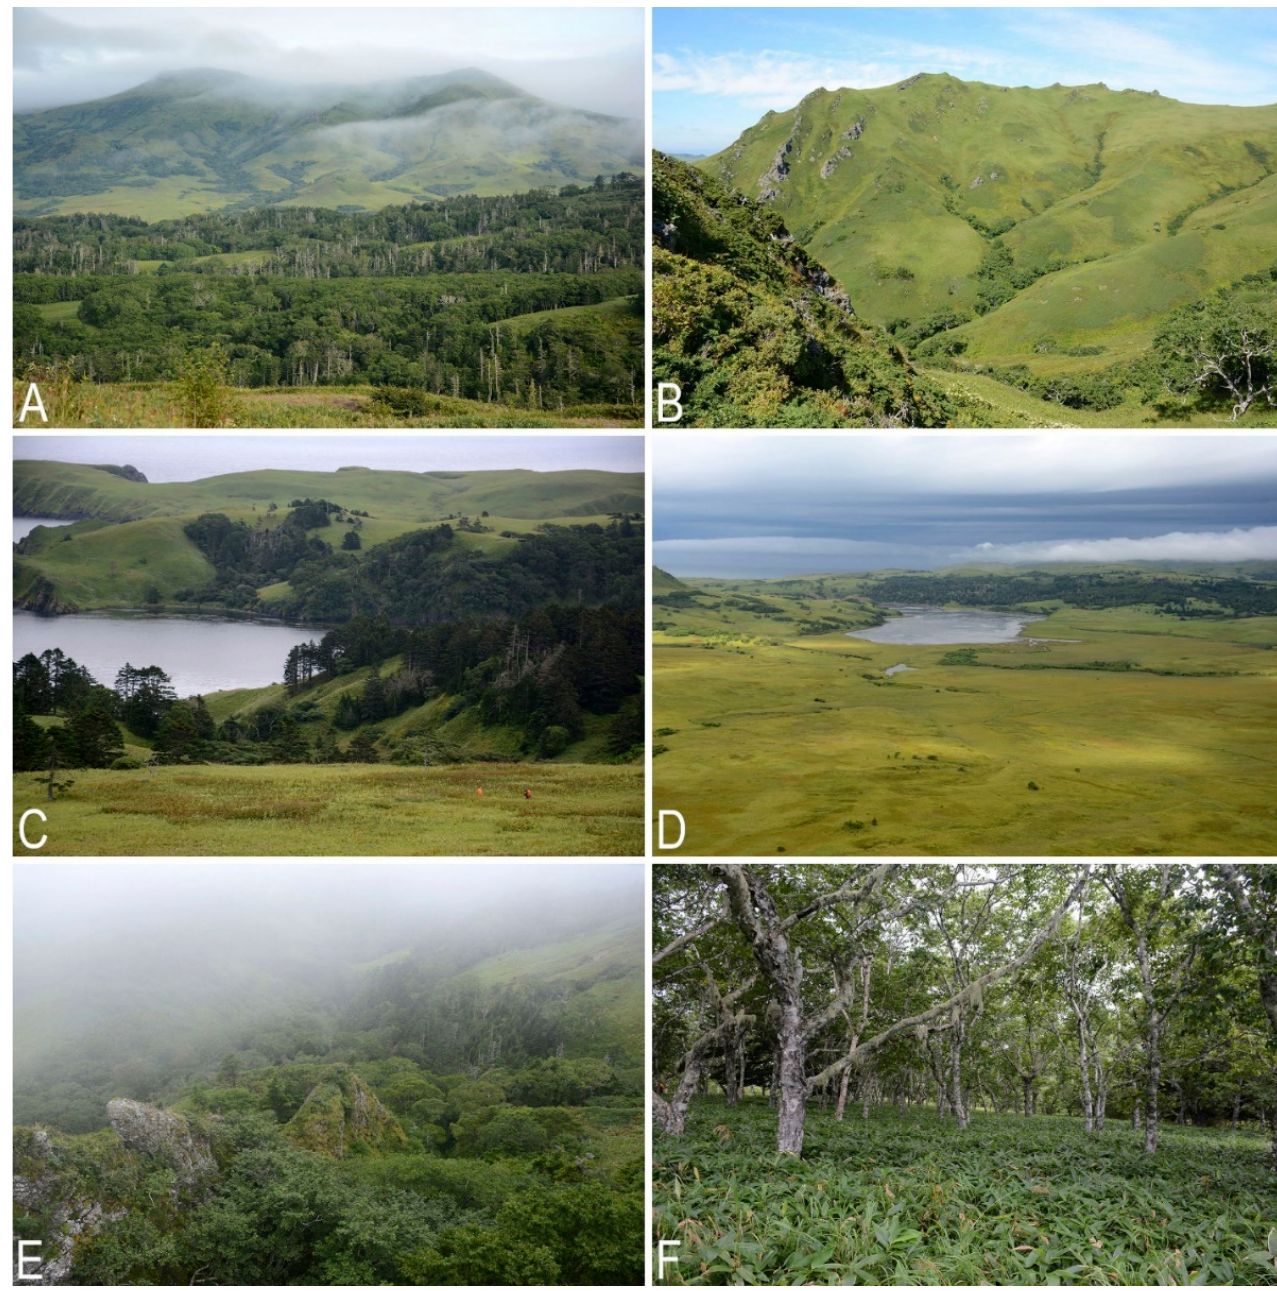
Figure 7. Liverwort habitats on Shikotan Island, southern part of the island: ( A ) Tomari Mt., view from the northwest, with Picea-Abies forests near the foot; ( B ) tundroid community ( Sasa, Eubotryoides, Empetrum , grasses, etc.) formed under severe wind condition, with low (less 50 cm in height) clumps of Juniperus sargentii , inner part of the Notoro Mt.; ( C ) Picea jezoensis forest in Tserkovnaya Bay area; ( D ) hummocky swamp complex with Carex, Phragmites, Dasiphora, Sphagnum, and green mosses southeastward of Delphin Bay; ( E ) extensive rocky outcrops on steep slope covered by Alnus forest with some Abies-Picea clumps and tundroid communities ( Sasa, Eubotryoides, Empetrum, grasses, etc.), northern spur of Ploskaya Mt.; ( F ) Betula ermanii forest with Sasa understory (Photo by K.G. Klimova, 2020).